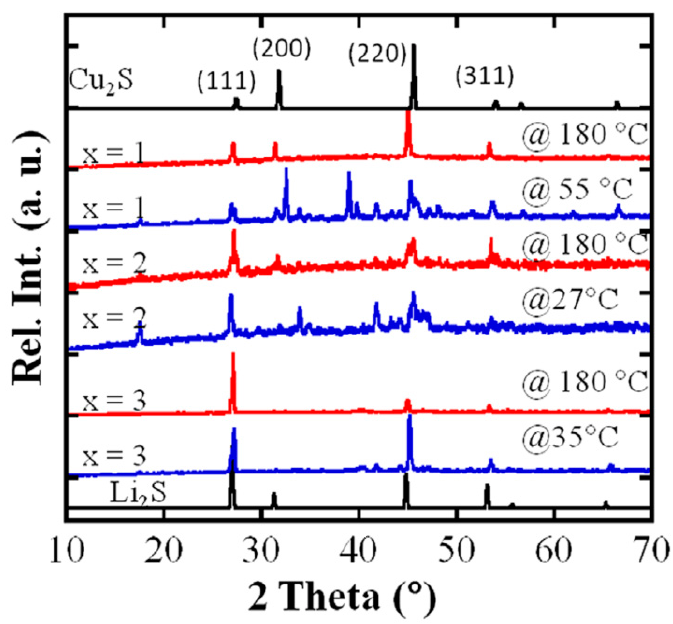
Figure 1. Temperature dependences of the X-ray patterns of the Cu 4 − x Li x S 2 series powders in comparison with the calculated diagrams of the Cu 2 S and Li 2 S powders. Reprinted with permission from ref. [77]. Copyright 2015 Elsevier.